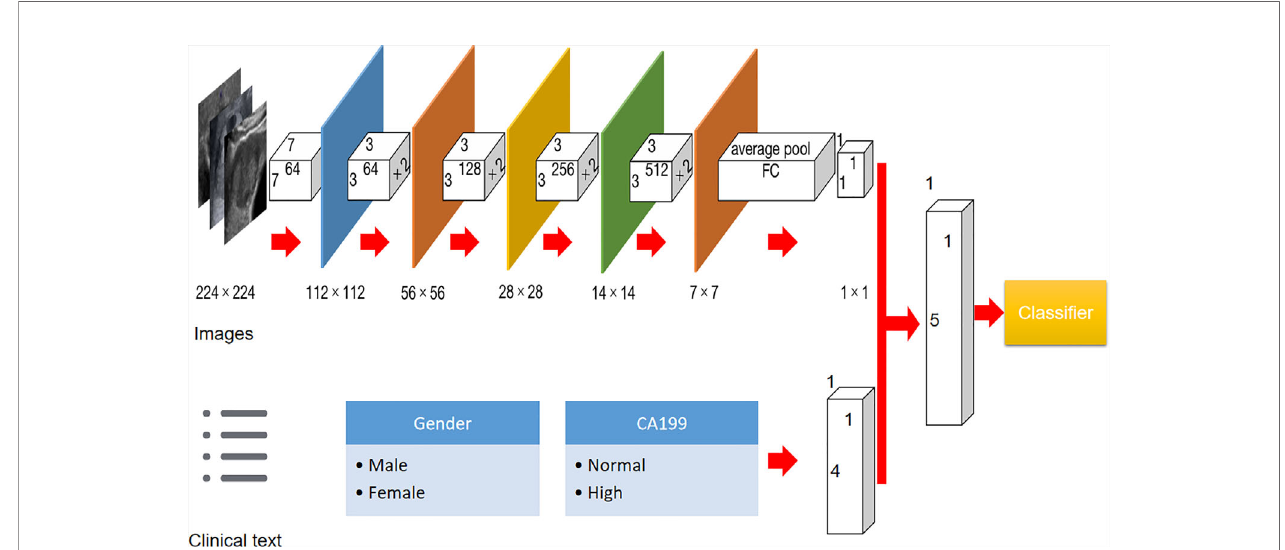
FIGURE 2 | Flowchart of development of US-based Resnet model for differentiating hepatocellular carcinoma and other malignancy in cirrhotic